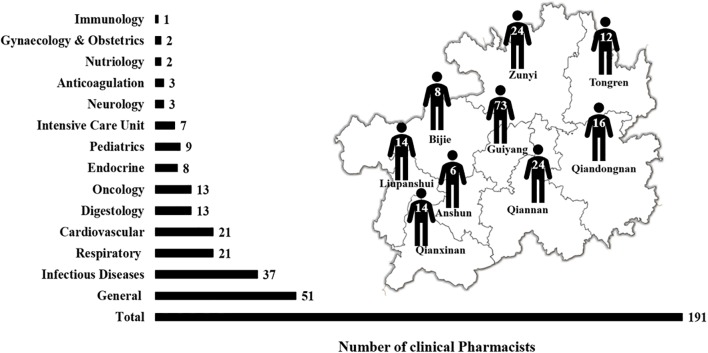
The major and distribution of clinical pharmacists.